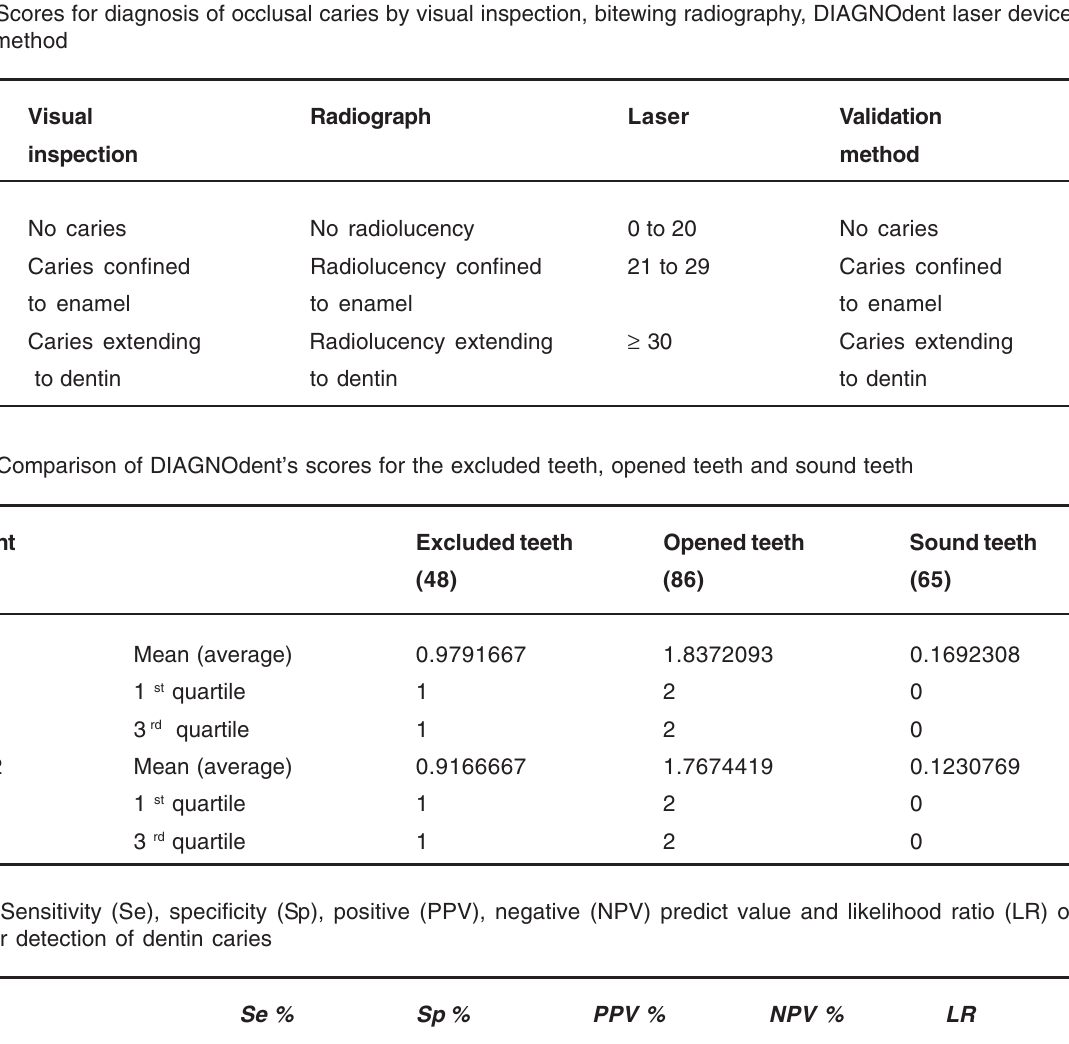
TABLE 1- Scores for diagnosis of occlusal caries by visual inspection, bitewing radiography, DIAGNOdent laser device and